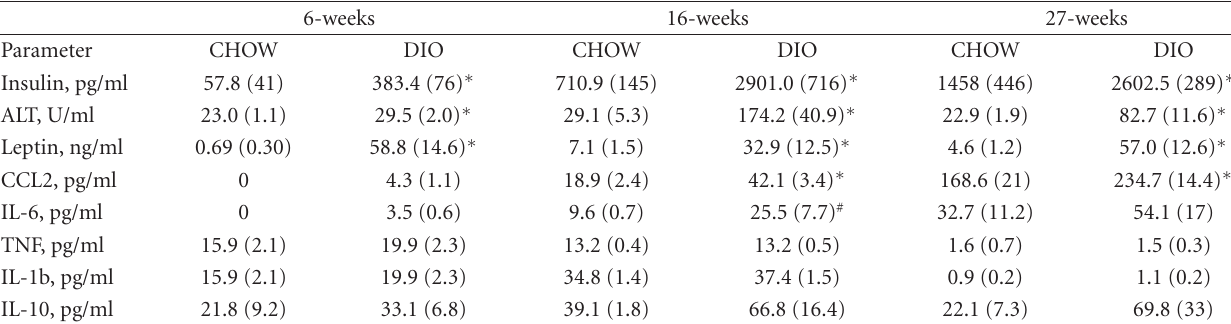
Table 2: Elevated serum metabolic parameters and inflammatory mediators in the DIO cohort. 6-weeks 16-weeks